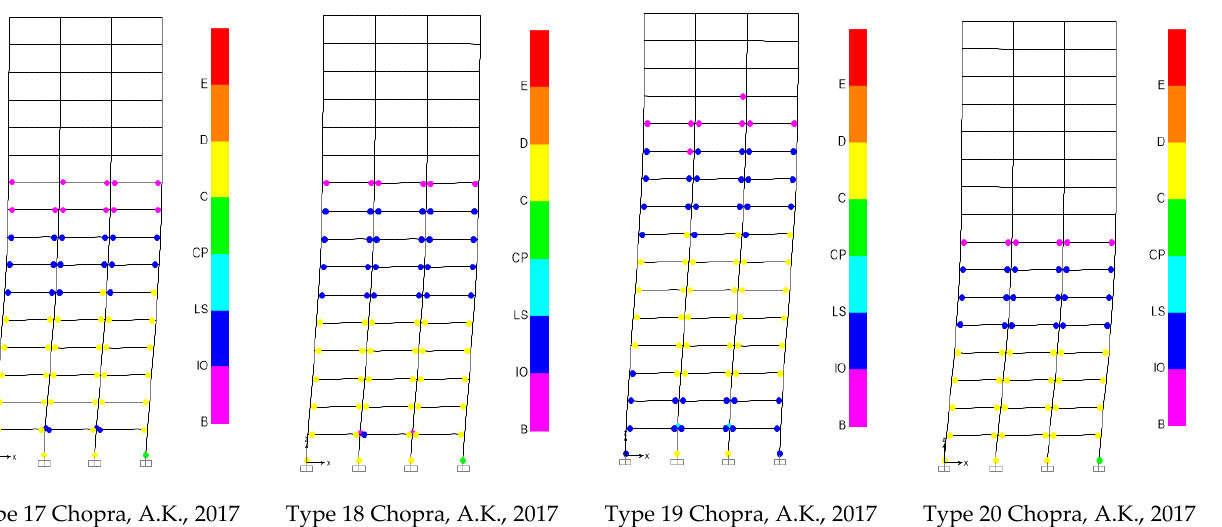
Figure 6. Failure mechanisms in the 16 story models according to different load patterns.